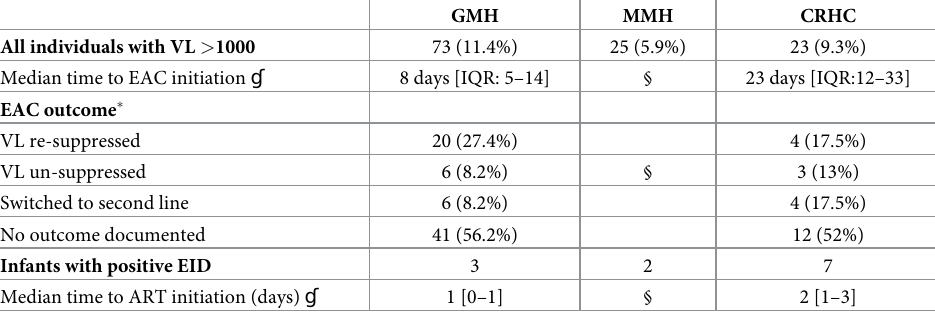
Table 3. Outcomes for patients tested on Xpert HIV-1 VL and HIV-1 Qual per